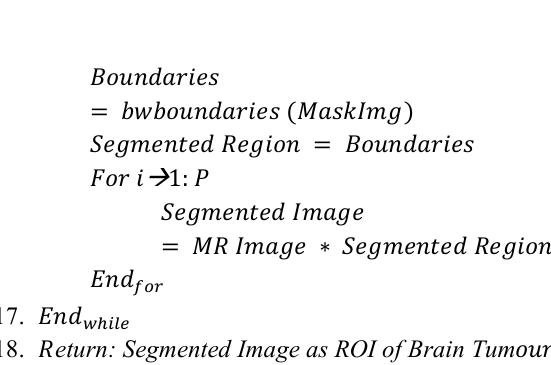
Figure 6. Segmentation using K-means with